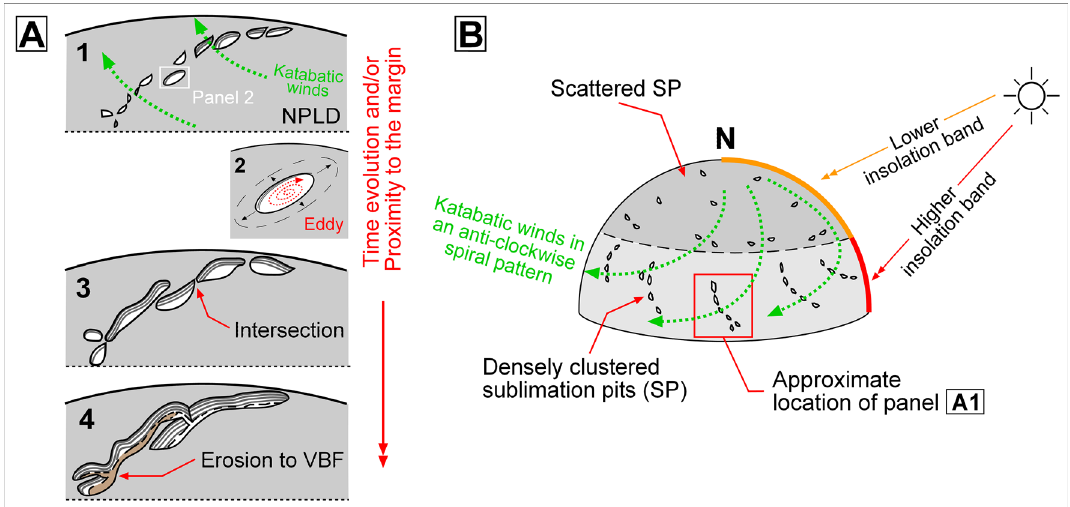
Figure 6. Sketches showing a geologic scenario that explains the formation of the north polar spiral troughs. Our model departs from the assumption that after the NPLD accumulated, PB had a smooth overall domical shape. Solar heating produced widespread sublimation pits ( A1 , B ), predominantly clustered along the polar plateau’s periphery due to higher insolation ( B ). The sublimation pits gradually grew obliquely to the